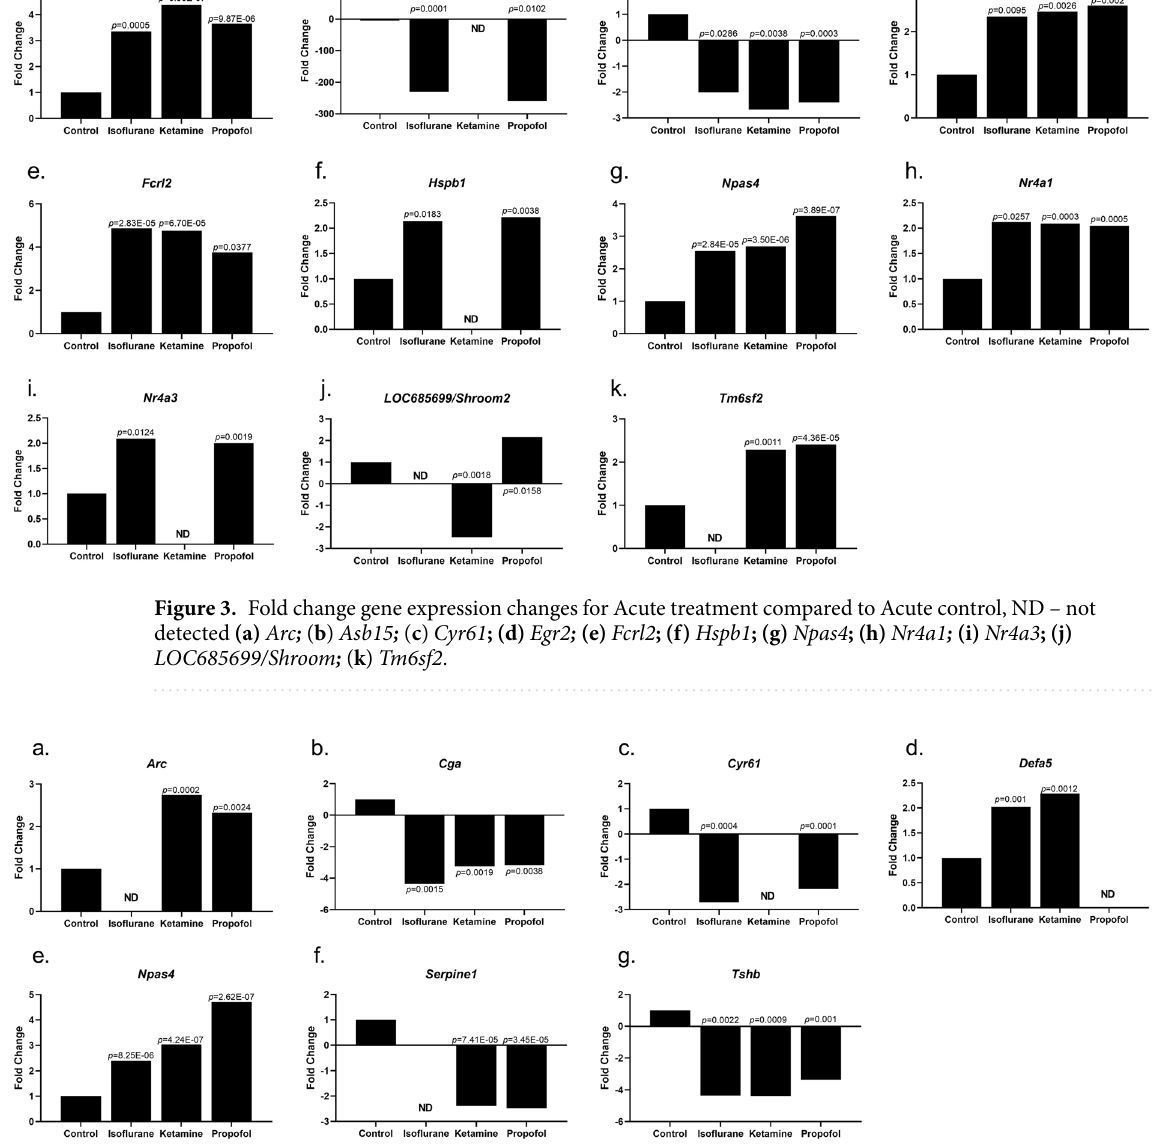
Figure 4. Fold change gene expression changes for Chronic treatment compared to Chronic control, ND – not detected (a) . Arc ; ( b ). Cga ; ( c ) Cyr61 ; ( d ) Defa5 ; ( e ) Npas4 ; (f) Serpine1 ; (g) Tsh